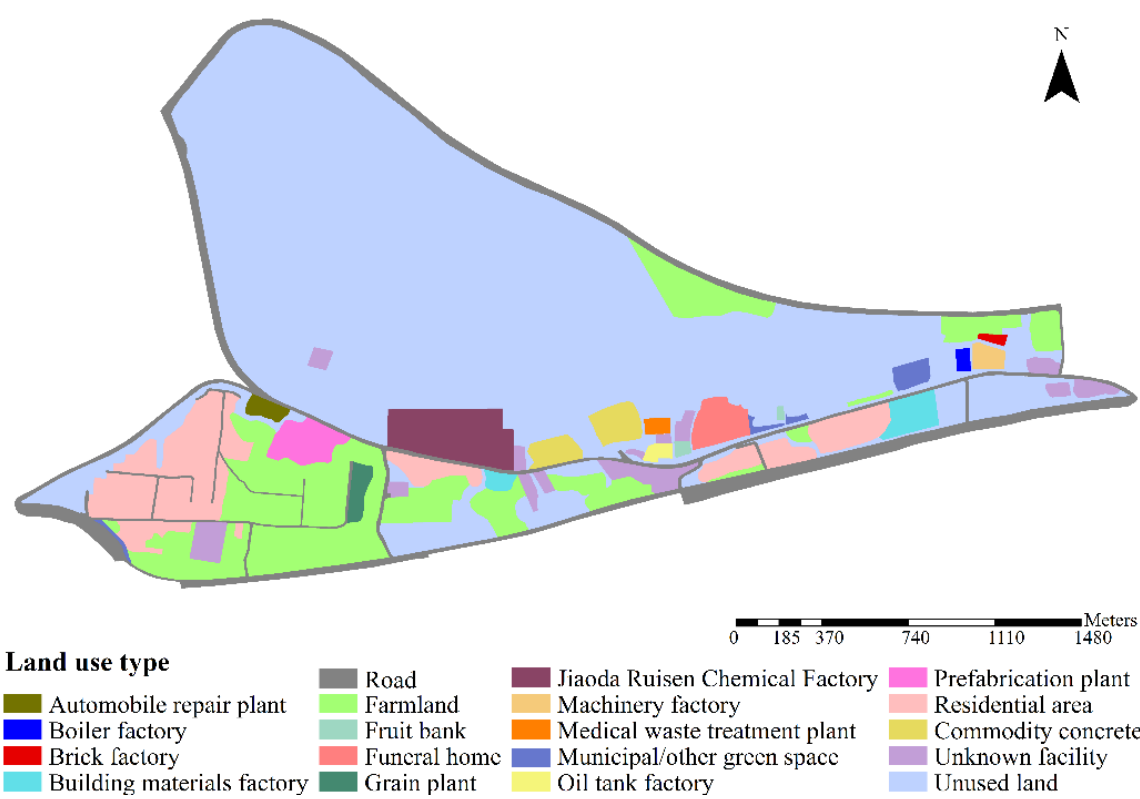
Figure 2. Distribution of facilities and enterprises in the study area. Table 1. List of pollutants that were likely contributed by facilities and enterprises in the study area. Plant